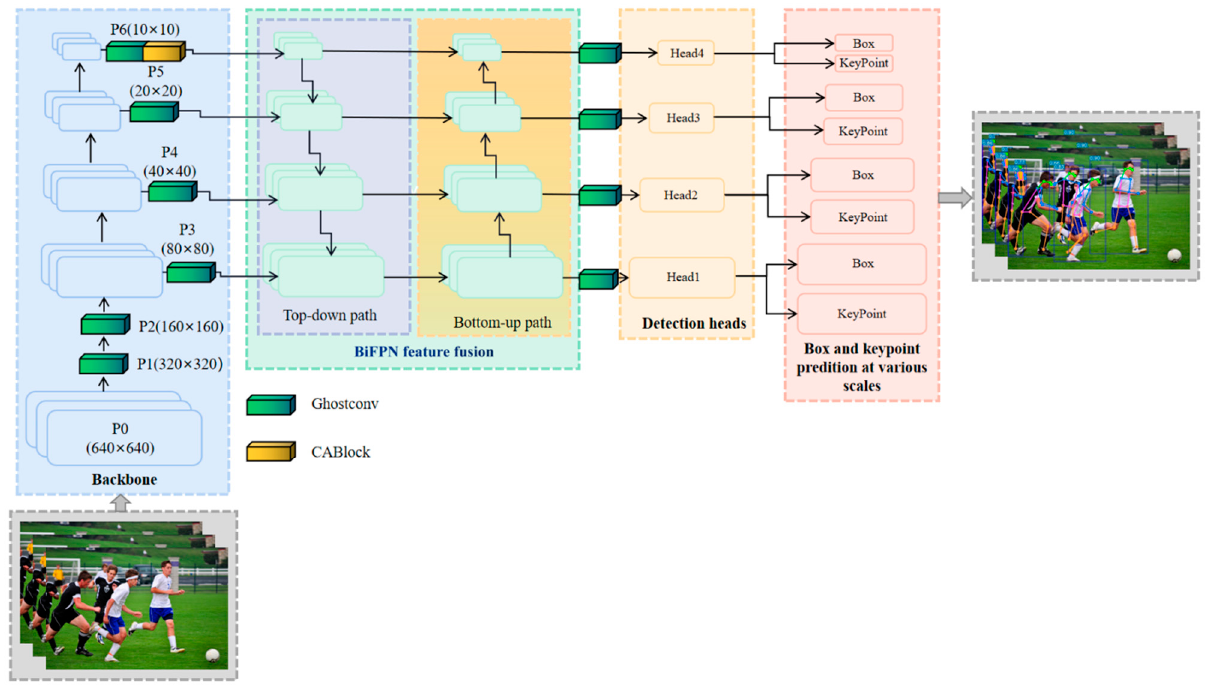
Figure 1. Lightweight Multi-scale Coordinate Attention Structure.